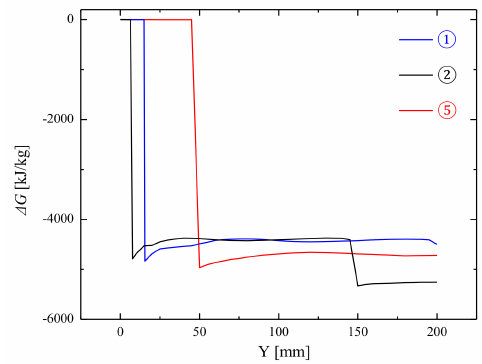
Figure 13. Variations in ∆ G increment along the three typical streamlines in an axial direction.